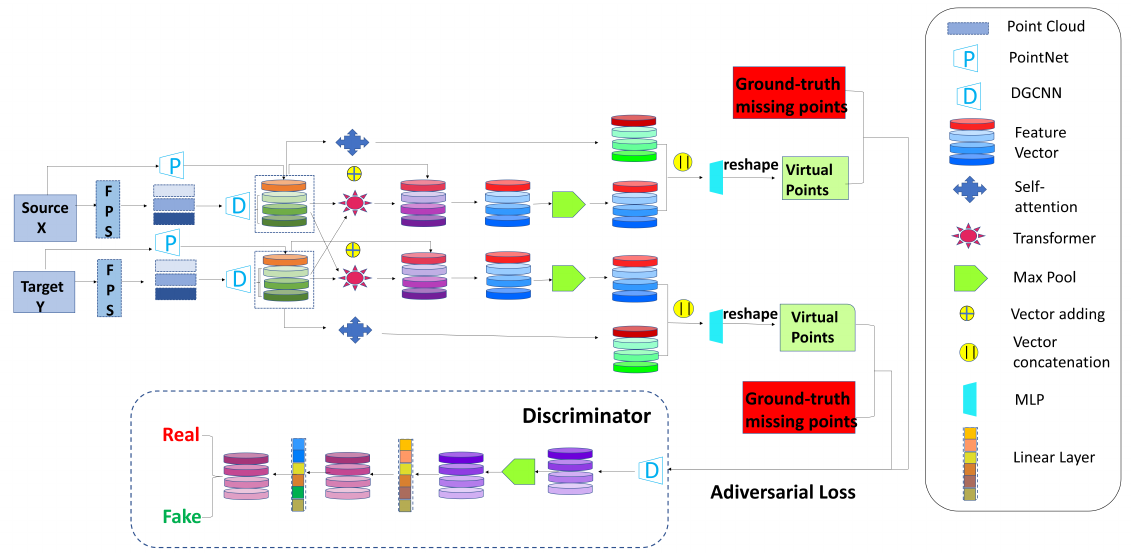
Figure 1. Architecture of our VPGnet. The self-supervised network is mainly composed of two parts, the generator and the discriminator. The generator sub-network extracts features through Self-Attention and Transformer, then MLP and Reshape operations are used to generate virtual points. Next, the features of the generated points and ground-truth are extracted through the DGCNN of the Discriminator and compared with each other. Finally the probability that the input point cloud is the ground-truth is